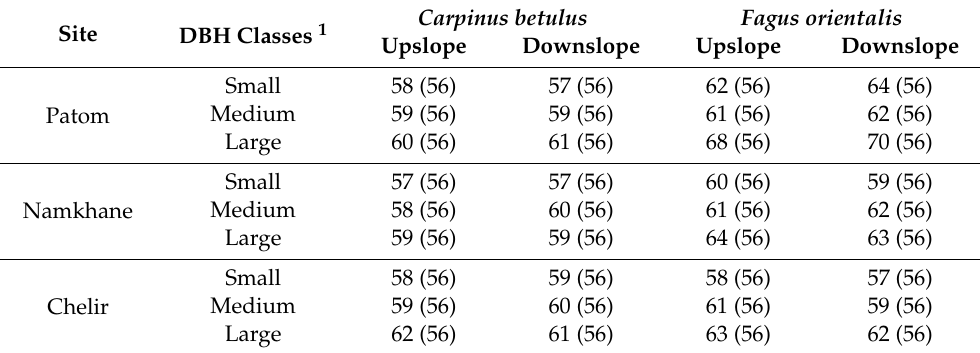
Table 2. Total number of root measurements attempted, and in parentheses, the attempts that yielded valid results, for each tree species, diameter at breast height (DBH) class, slope position relative to the main stem, and study